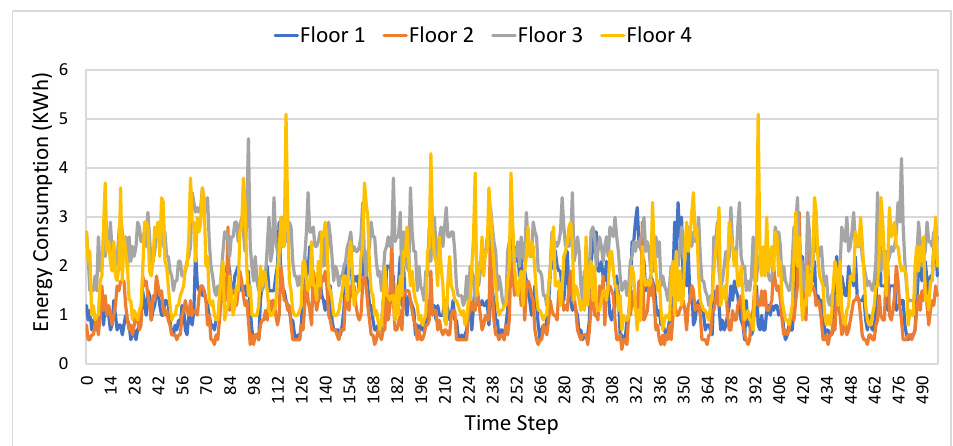
Figure 3. Hourly Electric Consumption data for Floor 1 and 2 (January 2010–July 2010). Figure 4 present monthly analysis of entire data-set using box plot representation